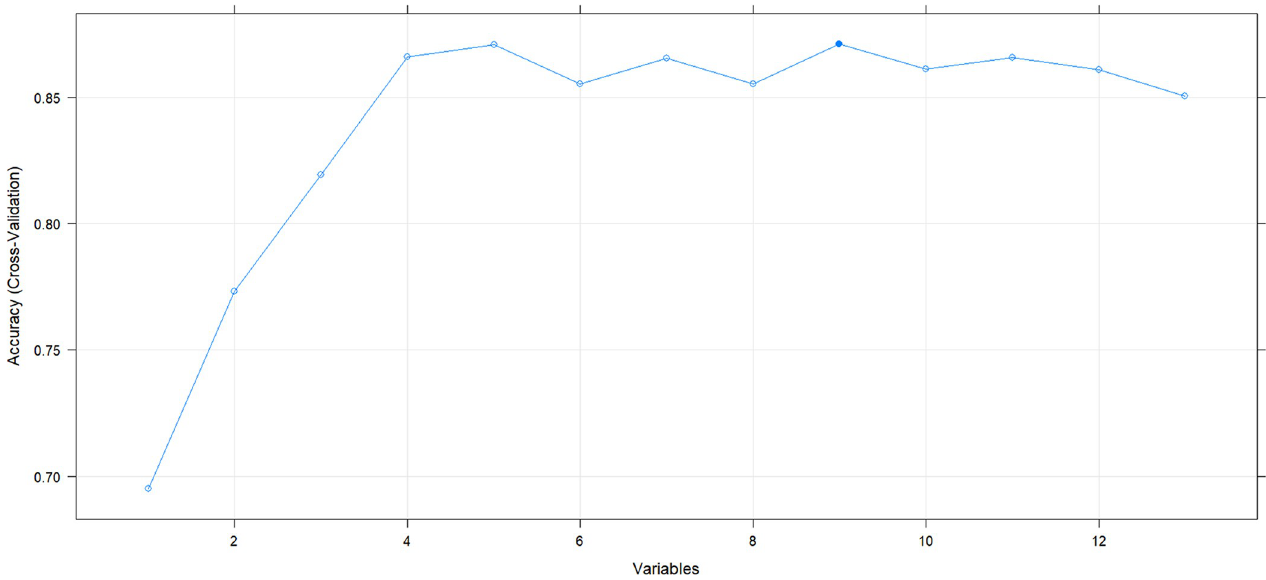
Fig 2. Optimal number of features in RF-models for very preterm infants with 27 to 30 WG.